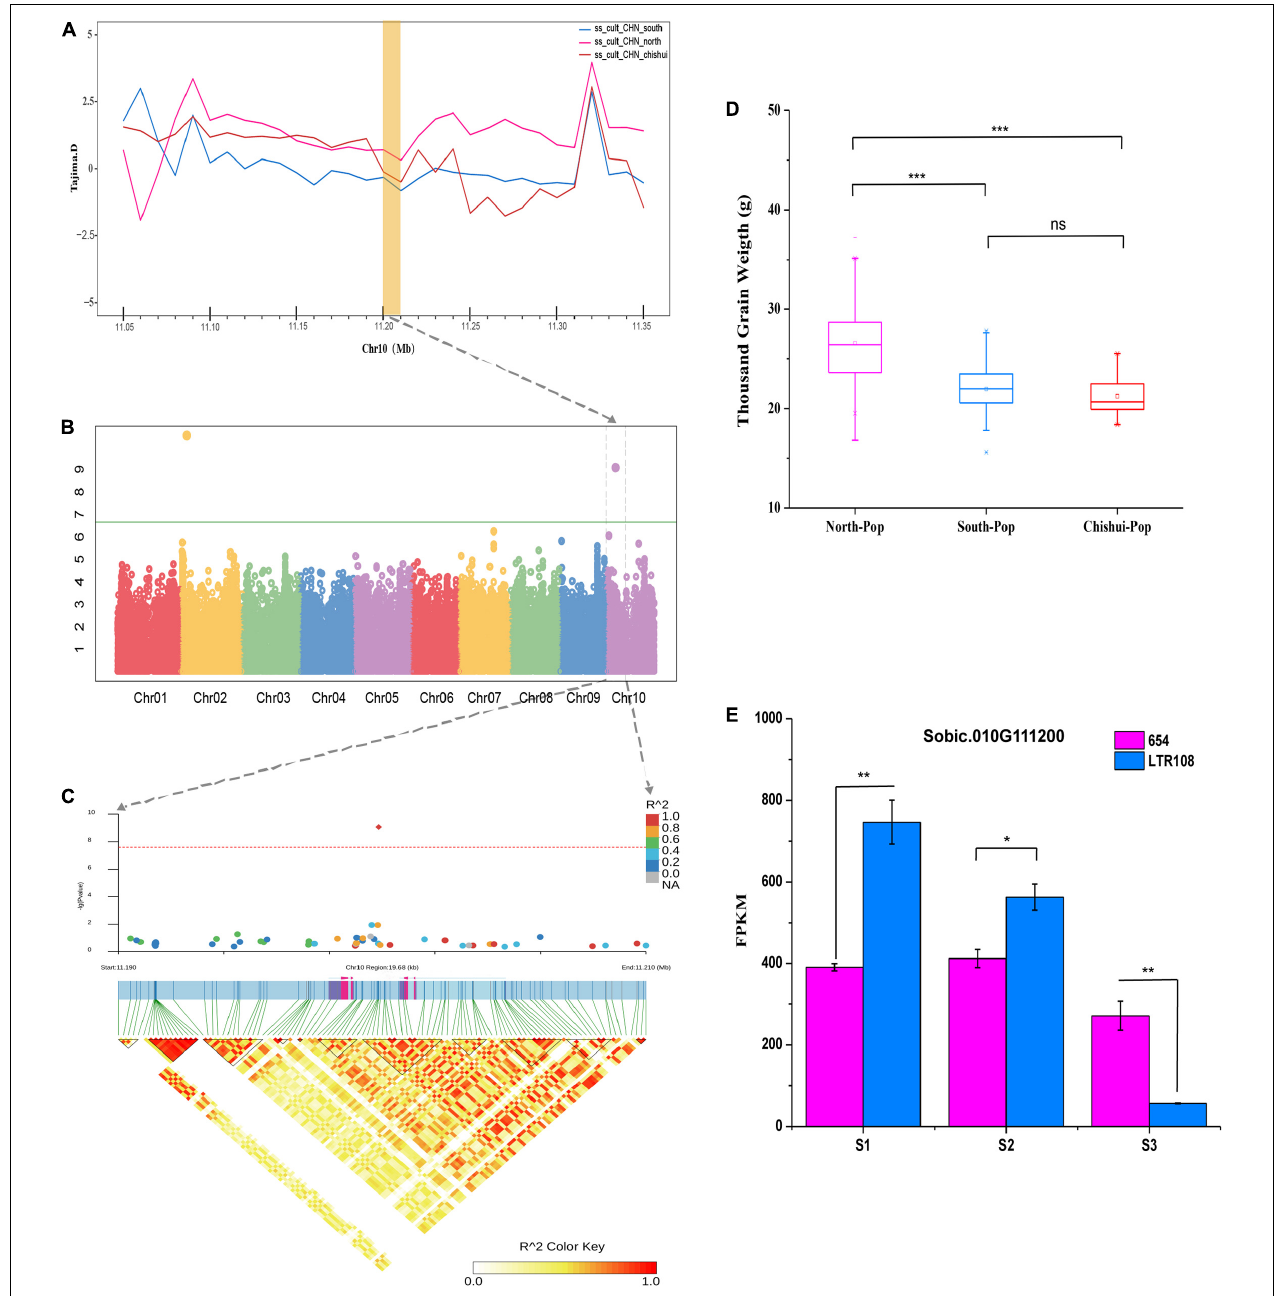
FIGURE 3 | Candidate gene (Sobic.010G111200) for TGW based on GWAS analysis. (A) Selective sweeps region for TGW based on Tajima’s D values among the South population, North population and Chishui population. (B) Manhattan plots for TGW using phenotype data from the 244-accession panel in Guiyang in 2019. (C) Local Manhattan plot (upper) of TGW and linkage disequilibrium (LD) heat map (lower). (D) Comparisons of TGW among South, North, and Chishui populations (*** P < 0.0001, ** P < 0.01, * P < 0.05, ns indicates no significance, Student’s T -test). (E) Expression pattern of total Sobic.010G111200 in 654 (smaller grain) and LTR108 (bigger grain) in various stages using transcriptome sequencing: S1, young panicle < 5 cm in length; S2, young panicle 10–15 cm in length; S3, panicle 5 days after heading. FPKM: Fragments per kilobase of transcript per million mapped reads.